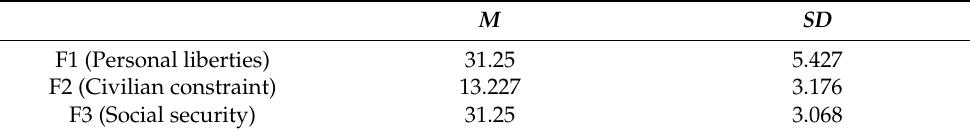
Table 3. Descriptive values of the ATHRI questionnaire factors.